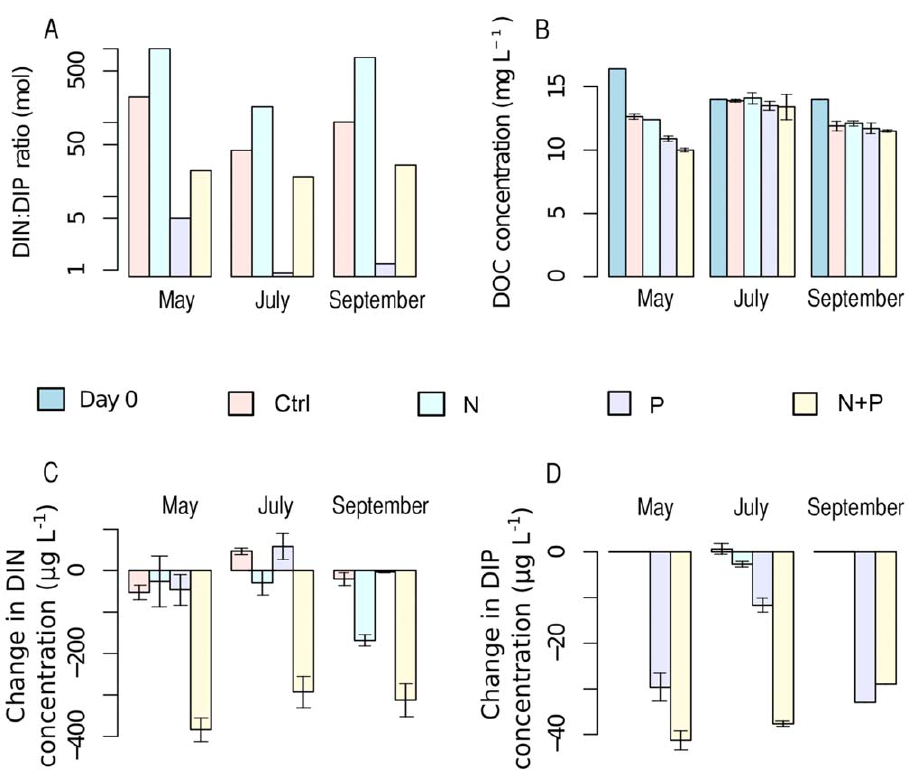
Figure 1. Nutrient and DOC concentrations in the experiments. DIN:DIP ratios in the lake and in the amended nutrient treatments on day 0 of each experiment, n=1 for all (A). Change in DOC concentration during experiments, n=1 for day 0 and n=4 for day 7 (B). Change in DIN concentration during experiments (C). Change in DIP concentration during experiments (D). In C-D the change is from day 0 to day 7 and n=4. Error bars represent standard